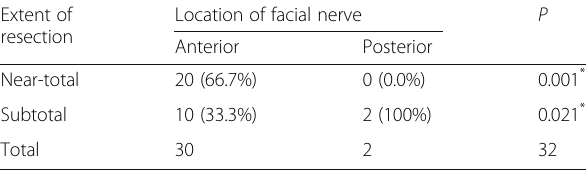
Table 3 Relation between the extent of resection and the location of the facial nerve in relation to the capsule Extent of Location of facial nerve resection